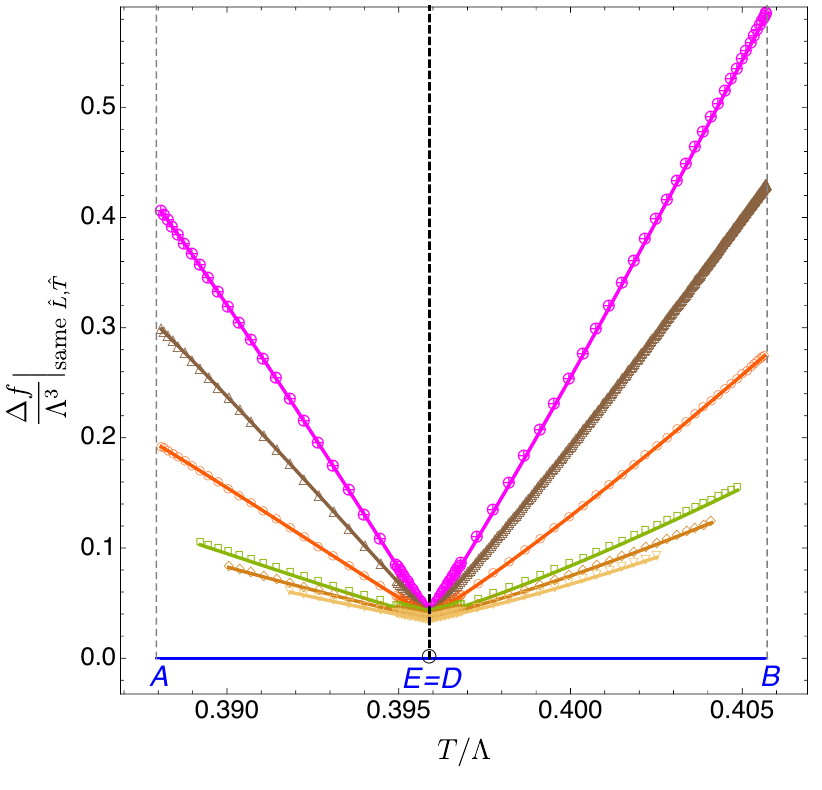
Figure 19 . Canonical phase diagram: dimensionless Killing free energy density difference (cid:12) ∆ ˆ f as a function of the dimensionless temperature ˆ T for the six lumpy-brane families (cid:12) sameˆ L, ˆ T at constant ˆ L already shown in figure 11 (with the same colour/shape code). Namely, from the bot- tom to the top the length of the curves are: ˆ L O ’ 5 . 299674 , ˆ L (cid:5) ’ 6 . 004224 , ˆ L (cid:3) ’ 6 . 900924 , ˆ L ’ 11 . 501849 , ˆ L 4 ’ 17 . 906849 , ˆ L ⊗ ’ 24 . 311849 . The black dashed vertical line with (cid:13) ˆ T = ˆ T ˆ T ˆ T D = E ≡ c ∼ 0 . 3958945 represents the critical temperature first identified in the right panel of figure 3 and the grey vertical dashed lines represent ˆ T = ˆ T A ∼ 0 . 387944 and ˆ T = ˆ T B ∼ 0 . 405724 between which lumpy branes coexist with uniform branes. The horizontal blue line with ∆ ˆ f = 0 represents the light uniform brane for ˆ T < ˆ T c , and the heavy uniform brane for ˆ T > ˆ T c . ˆ of this plot at constant ˆ L . Gluing slices of this type together along the E -axis one obtains ˆ the three-dimensional plot of ∆ˆ σ (cid:12) (cid:12) versus (ˆ L, E ) . The ˆ L → ∞ limit of the curves of sameˆ L, ˆ ρ figure 18 is the curve in figure